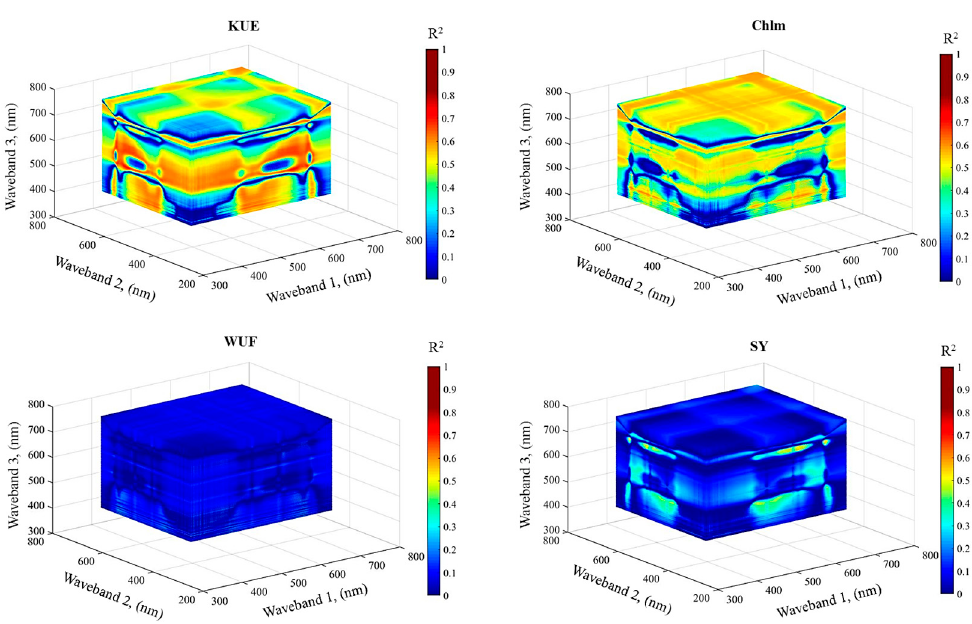
Figure 2. Correlation matrices displaying estimated (R 2 ) values for all potential three-band spectral combinations with potassium-use efficiency (KUE), chlorophyll meter (Chlm), water-use efficiency (WUE), and seed yield (SY) of squash across two successive seasons (spring and fall seasons).